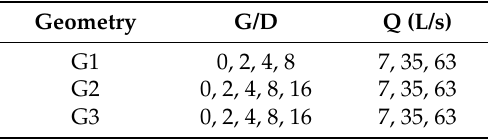
Table 3. Test Table 3 . Test setups.